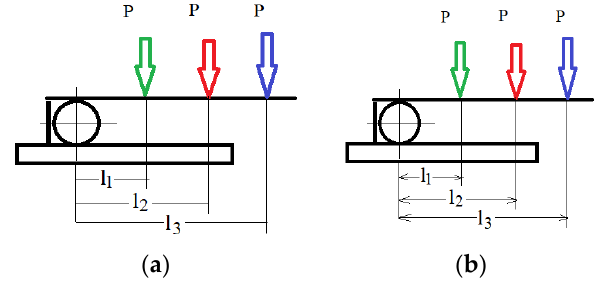
Figure 5. ( a ) Deflection of Ni-Cr arcs; ( b ) deflection of Co-Cr.